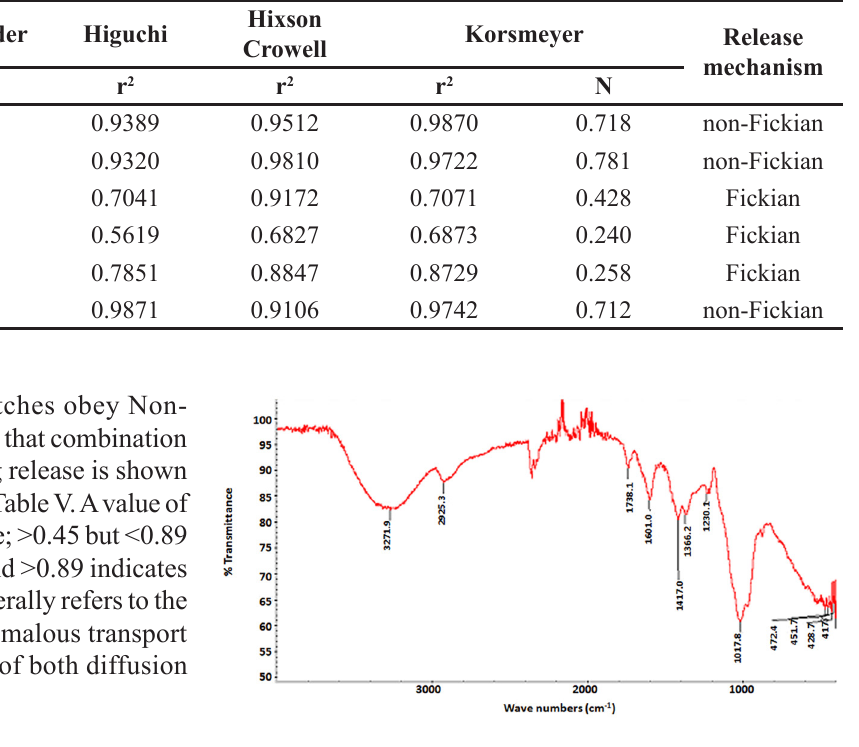
FIGURE 2 – FTIR spectrum Prunus domestica gum.